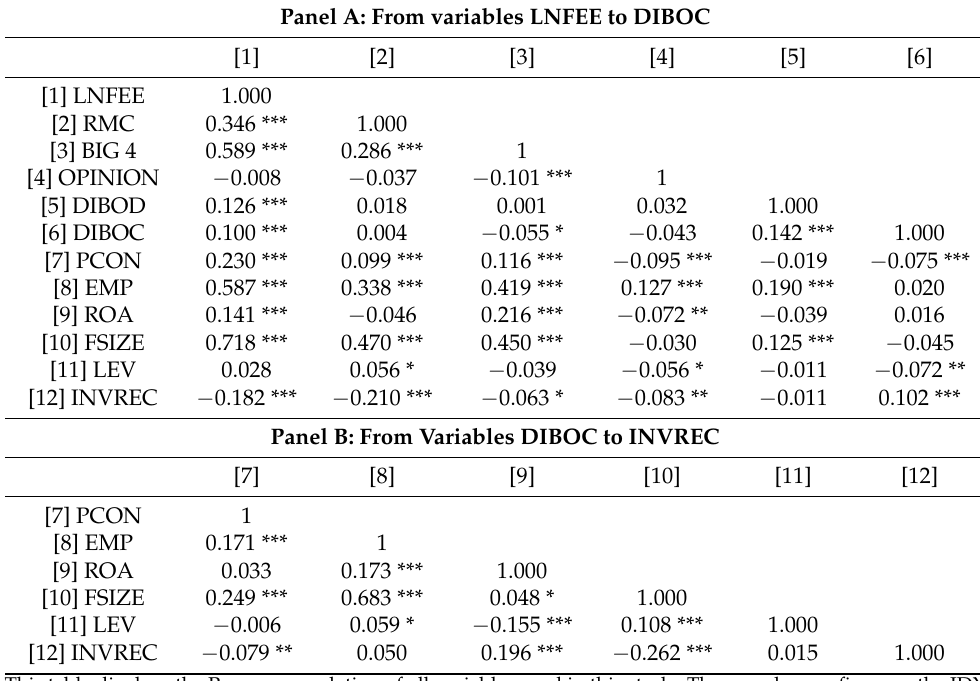
Table 5. Pearson